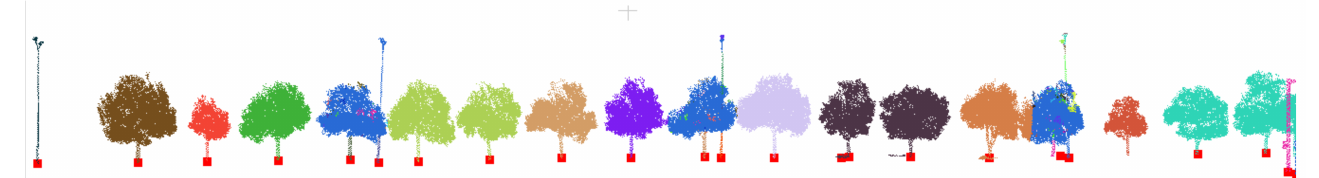
Figure 9. The coordinates of the pole-like objects. Different colors represent the result of Euclidean clustering and the red points represent the coordinates of each pole-like